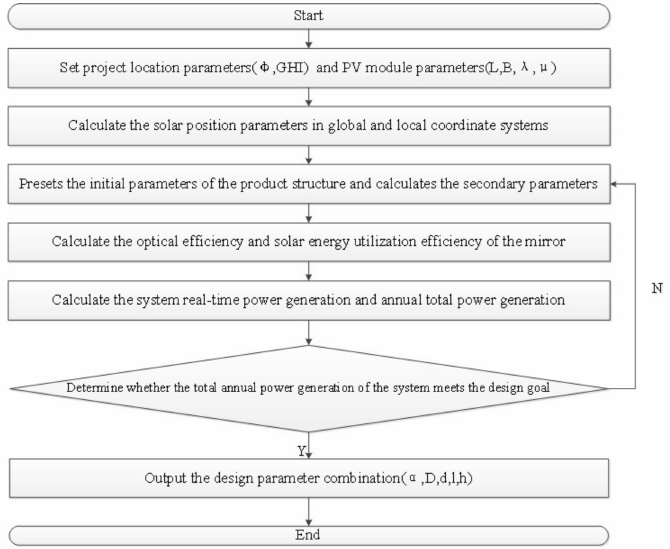
Figure 4. Calculation process for the design optimization of the bifacial companion